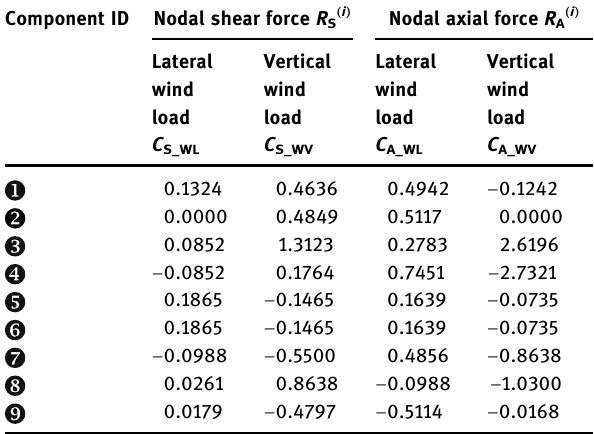
Table 5: Correlation between nodal force and wind pressure ( Unit: N/Pa ) Component ID Nodal shear force R S ( i ) Nodal axial force R A ( i